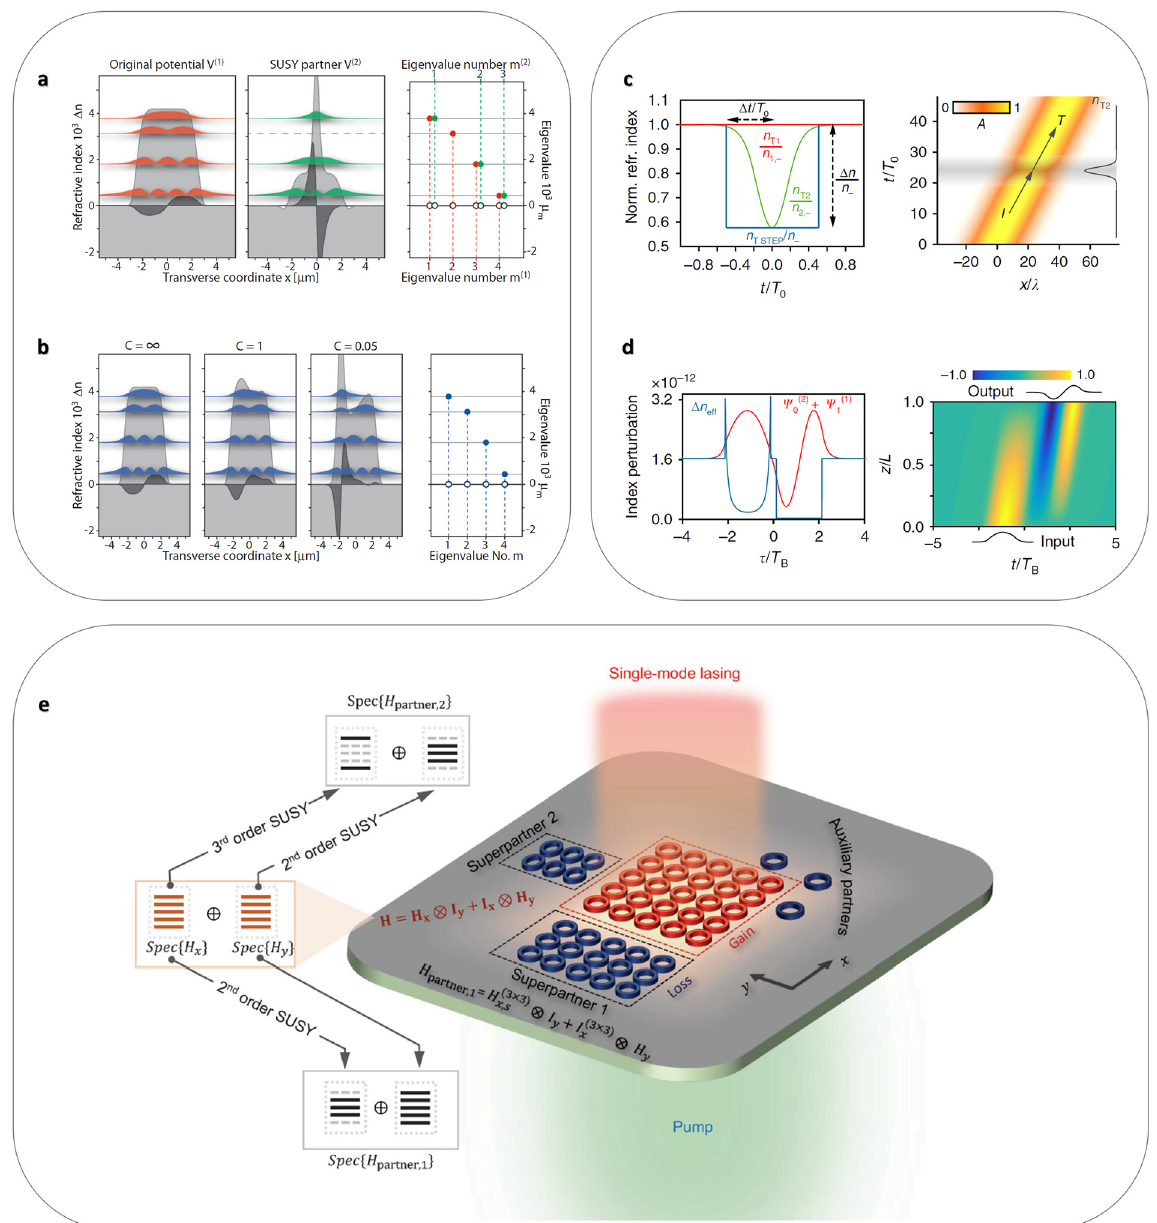
Figure 4: Generalized SUSY photonics. (a and b) Non-Hermitian SUSY transformations [48]. (a) Excited-state annihilation [48]. For a PT-symmetric multimode waveguide (orange: bound states), the SUSY transformation removes the second mode (green). Right fi gure: the eigenvalue spectra of the structures. (b) Non- PT-symmetric conservative potentials [48]. By controlling an arbitrary integration constant C for the general solution of the Riccati equation, non-PT-symmetric SUSY partners with real eigenspectra are achieved. Right fi gure: identical eigenvalue spectrum of the structures. (c and d) TemporalSUSYtransformations[60].(c)Re fl ectionlesstime-varyingmaterial[60].Red,green,andbluelinesdenotetheconstantpotential,its SUSYpartner,andsquarewell. Δ t / T 0 and Δ n / n – areobtainedfromthetemporalSUSYtransformationforthe fi niterange,where T 0 =2 π / ω 0 and ω fi gure: scattering-free propagation in the SUSY partner (green line in the left fi gure). (d) Pulse-shape 0 is the center frequency. Right transformer[60].Blueandredlinesdenotethetime-varyingpotential Δ n eff andoverlappingeigenmodes Ψ 0 (2) + Ψ 1 (1) ,where Ψ 0 (2) (or Ψ 1 (1) )isthe fi rst-excited (or ground) state in the right (or left) potential. The left potential is the SUSY partner of the right potential. The right fi gure shows the modal transformation along the temporal axis. (e) Higher-dimensional SUSY microlaser array [65], composed of an original gain system (redarray)anditshigher-order (2nd-and3rd-order)SUSYpartners(bluearrays).Decomposingthe entirespectrumto aKroneckersumallows the 1D SUSY transformation to each axis. Three auxiliary lossy elements are included for the complete dissipation of excited states. Panels (a and b) are adapted with permission from [48], ⓒ APS. Panels (c and d) are adapted from [60], CC BY 4.0 (https://creativecommons/org/ licenses/by/4.0/). Panel (e) is adapted with permission from [65], ⓒ